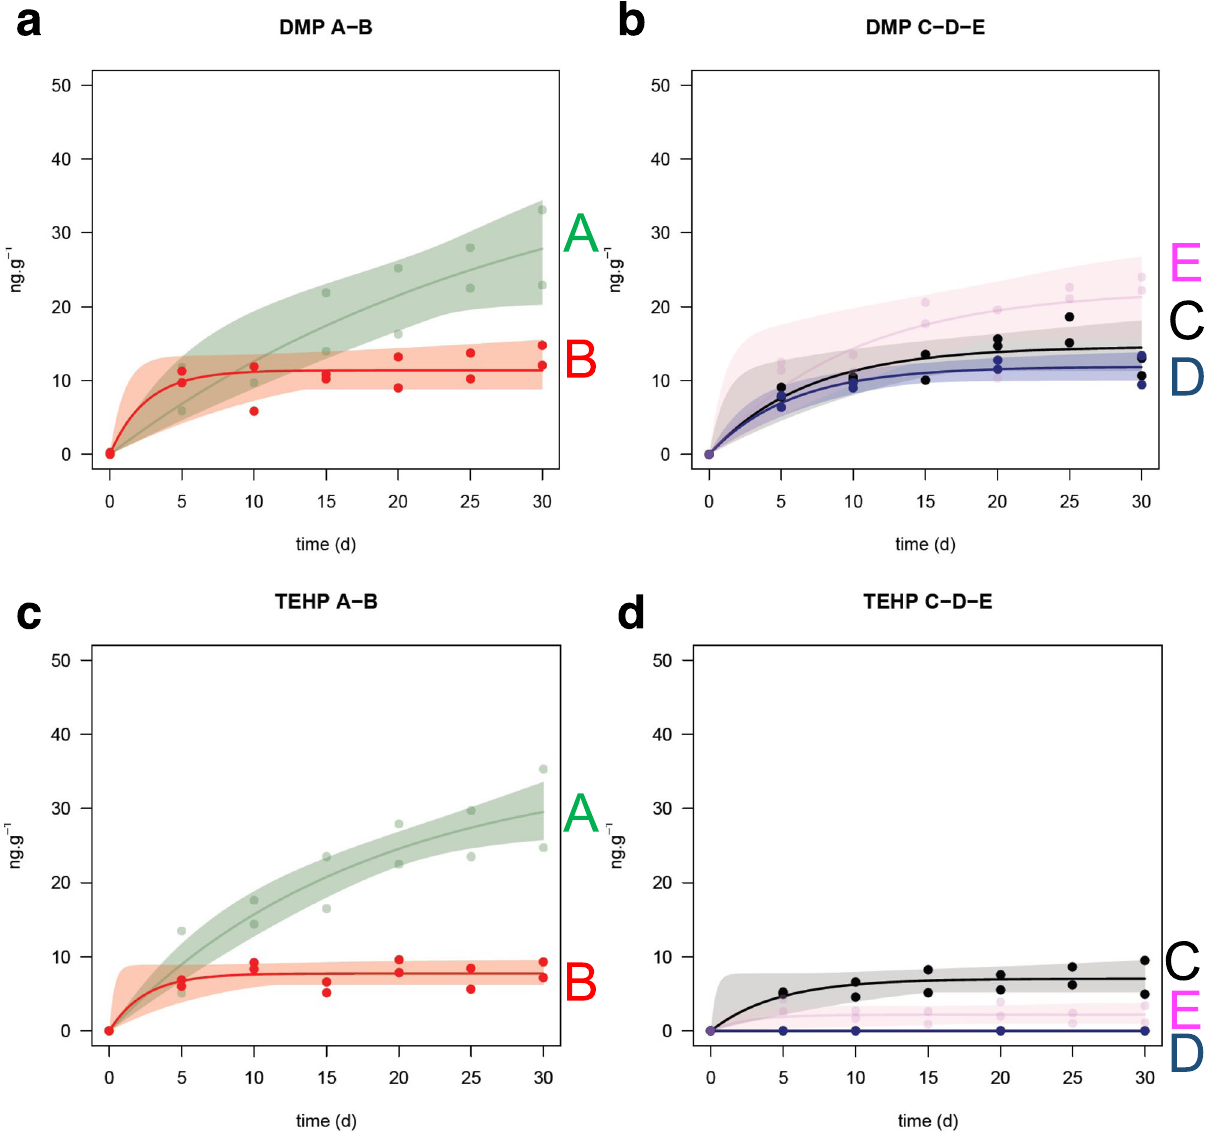
Fig. 1 Additive release from polyethylene. DMP (dimethyl phthalate, a , b ) and TEHP (tris(2-ethylhexyl) phosphate, c , d ) leaching and associated 95% con fi dence intervals from polyethylene over a 30-day exposure under varying hydrostatic pressure and biology. Solid lines are obtained from fi rst-order kinetic fi tting. TEHP is representative of more hydrophobic and higher molecular weight compounds and DMP is representative of more hydrophilic and lower molecular weight compounds. Treatments A, B, C, D, and E correspond to those mentioned in Table 1: surface seawater, 0.1 MPa, biotic (A, left column, green); surface seawater, 0.1 MPa, abiotic (B, left column, red); deep seawater, 0.1 MPa, abiotic (C, right column, black); deep seawater, 10 MPa, abiotic (D, right column, blue); deep seawater, 10 MPa, biotic (E, right column,